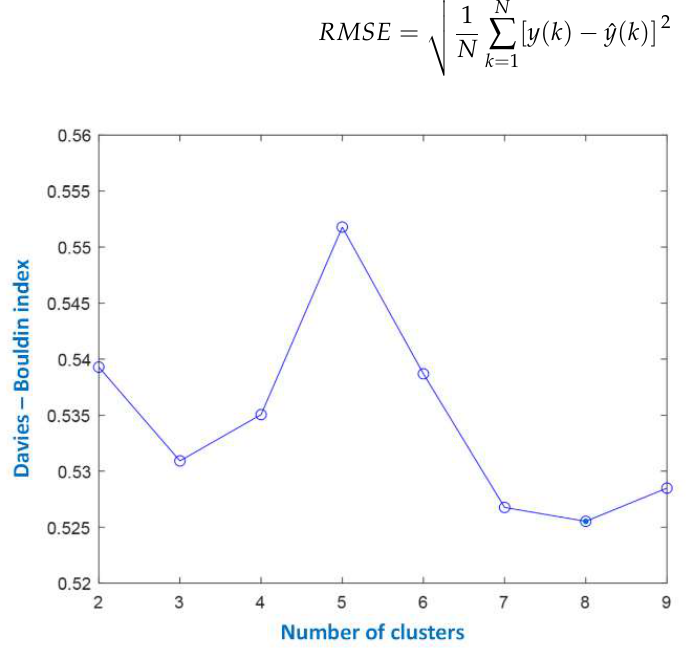
10 of 19 Table 1. Premise and consequent parameters (weights) of ReNFuzz-LF. Parameter